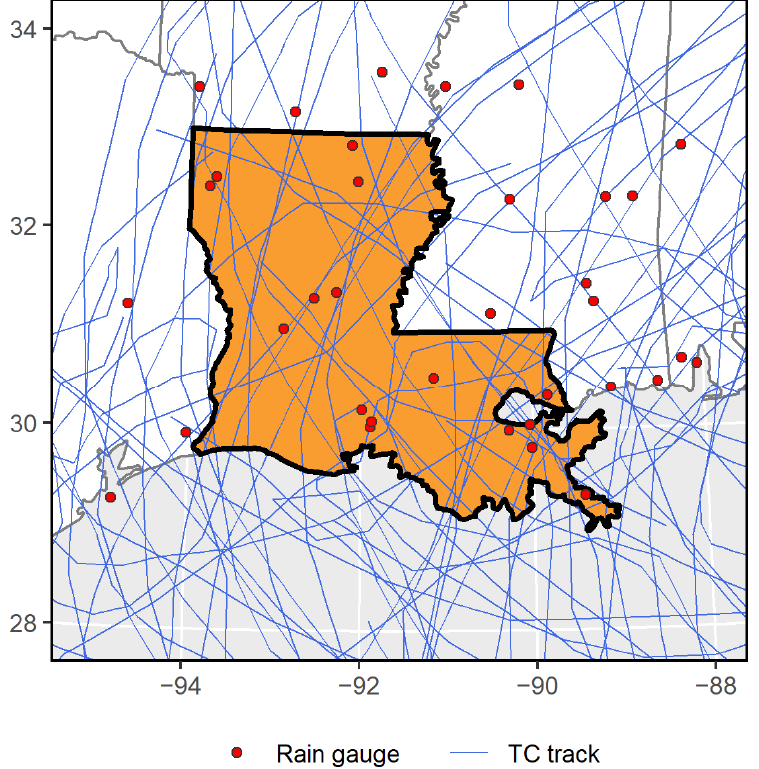
Figure 1. Study area encompassing Louisiana. Red dots represent the location of the reference rain gauges. Blue lines are the tracks of tropical cyclones passing through the study area from 1981 to 2020.